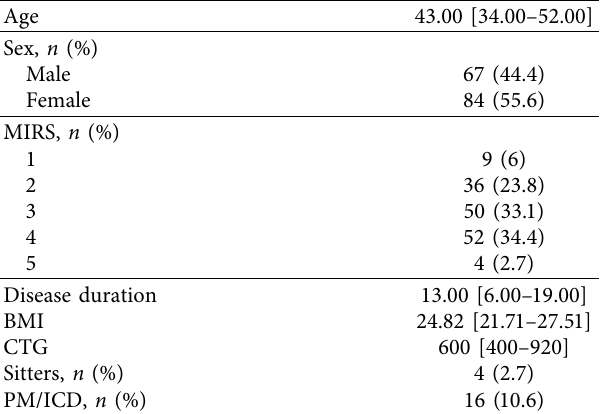
All data are presented as median and interquartile ranges, except where otherwise indicated. Patients were classified as “sitters” if unable to walk for